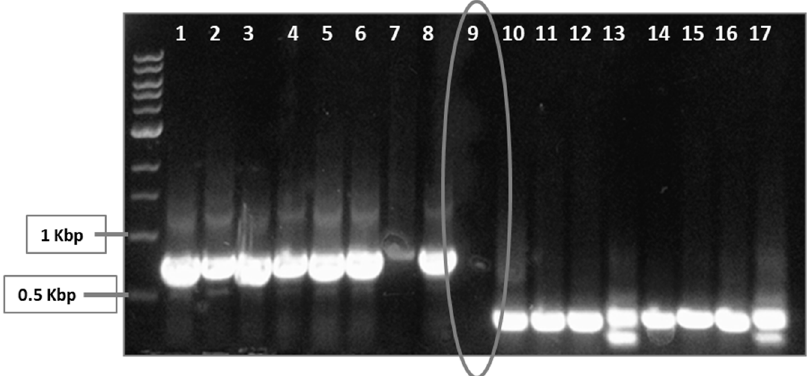
Figure 2. Screening for positive and negative clones, using PCR. Transformed S. enterica cells were selected on LB-kanamycin/chloramphenicol plates. Two plasmids were employed herein: The first